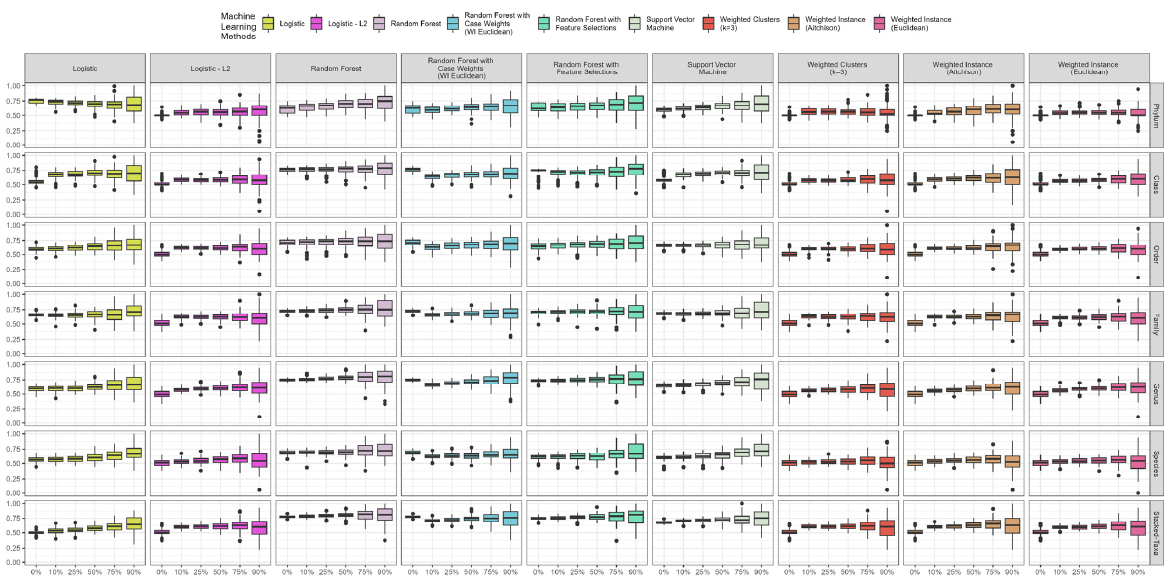
Figure 4. Area under the receiver operating curve for selected machine learning methods across different examined combinations. The x-axis represents the percentage of target samples combined into the source data to form the training data frame, which ranged from 0% (baseline, no leveraging) to 90%. The y-axis represents the area under the receiver operating curve, and the solid black dot represents the outliers. The plot illustrated the results from 75% of features/taxa shared between two colorectal cancer datasets.